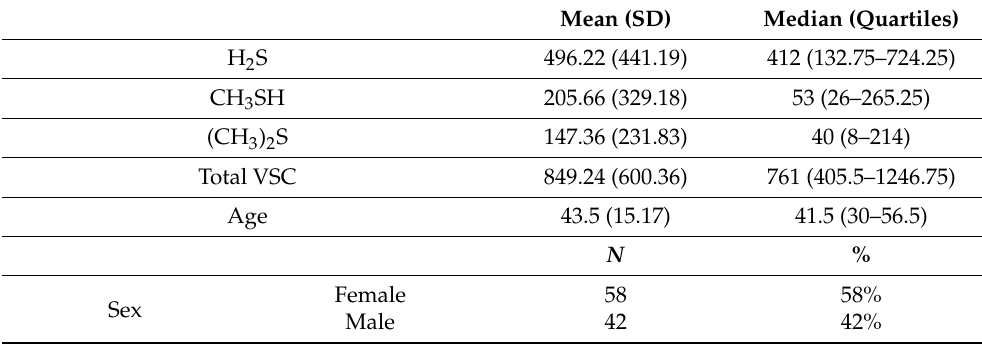
Table 1. The description of the study population.